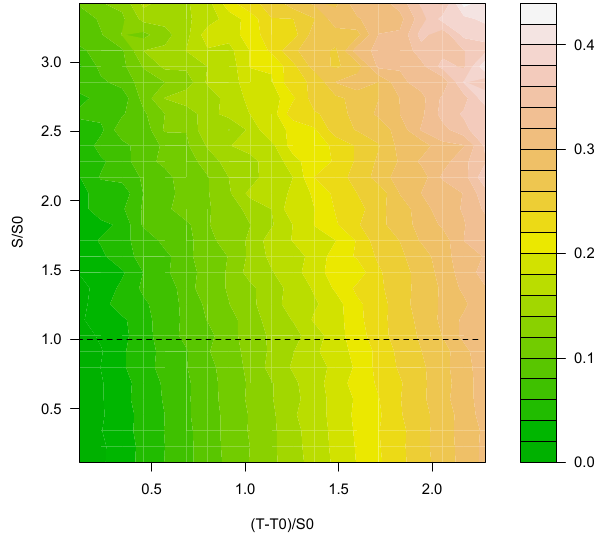
Fig. 5. MSC plots for H.J. Andrews using the modified van’t Hoff equation and Q 10 = 4 , 3 , 2 , for panels a, b, and c, respectively. Con- tours represent values of δR , i.e., the proportional increase in respi- ration over 10 years from one climatic regime over the other.